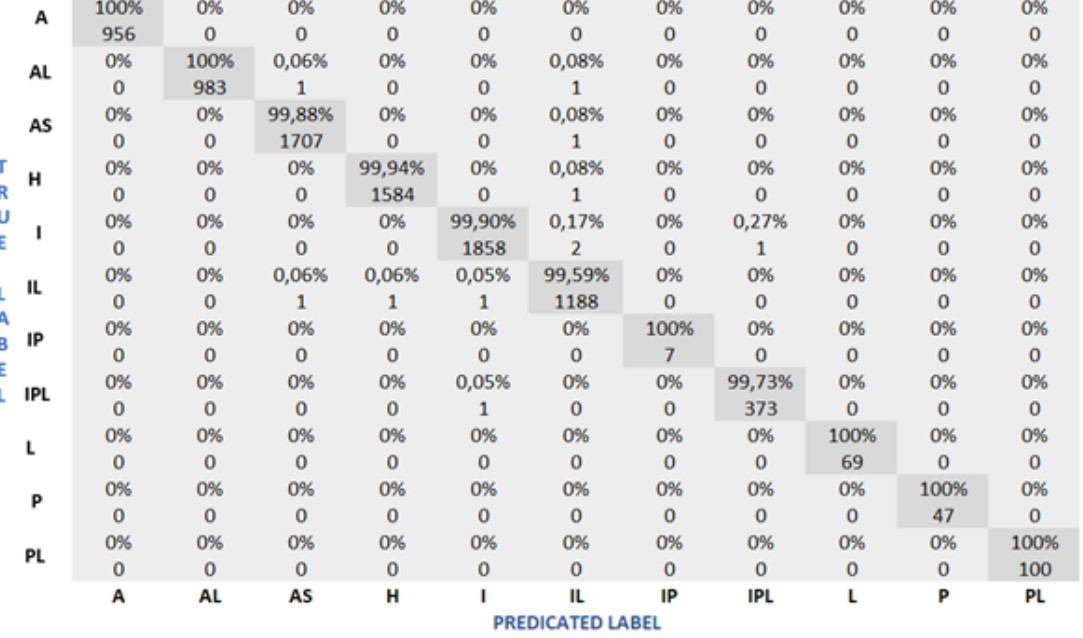
Figure 6. Confusion Matrix 10 class MI and Normal in lead v2.